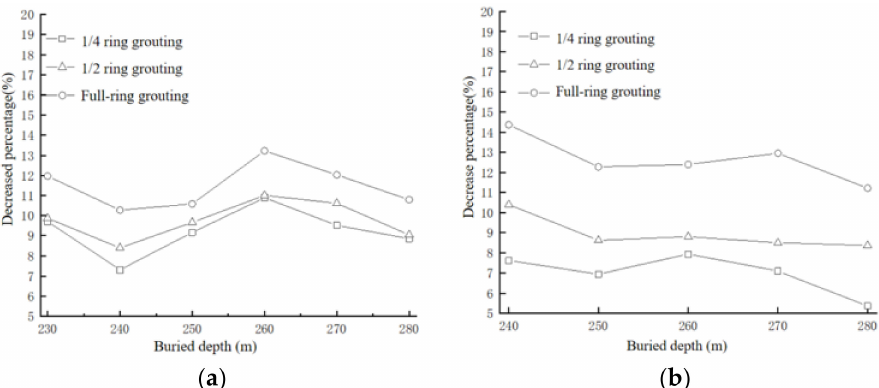
Figure 8. Decreased percentage of the maximum displacement of crown settlement under different surrounding rock grades (compared with no grouting). ( a ) Grade IV surrounding rock; ( b ) Grade V surrounding rock.